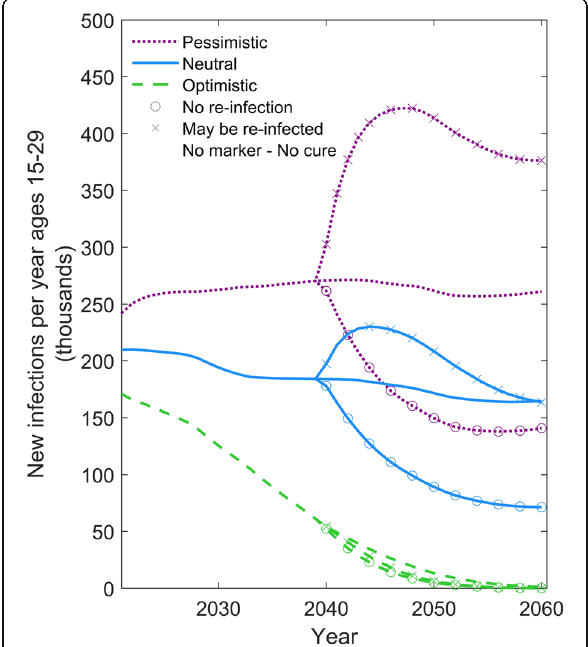
Fig. 3 Comparison of a curative intervention that prevents re-infection versus one that allows re-infection. Comparison of scenarios in which a curative intervention either allows for re-infection or prevents subsequent re-infection. The y-axis shows the number of individuals aged 15 – 29 newly infected with HIV per year. The green dashed, blue solid, and purple dotted lines represent the optimistic, neutral, and pessimistic epidemic forecasts, respectively (see Table 1). The symbols on the line denote the alternative scenarios for the cure